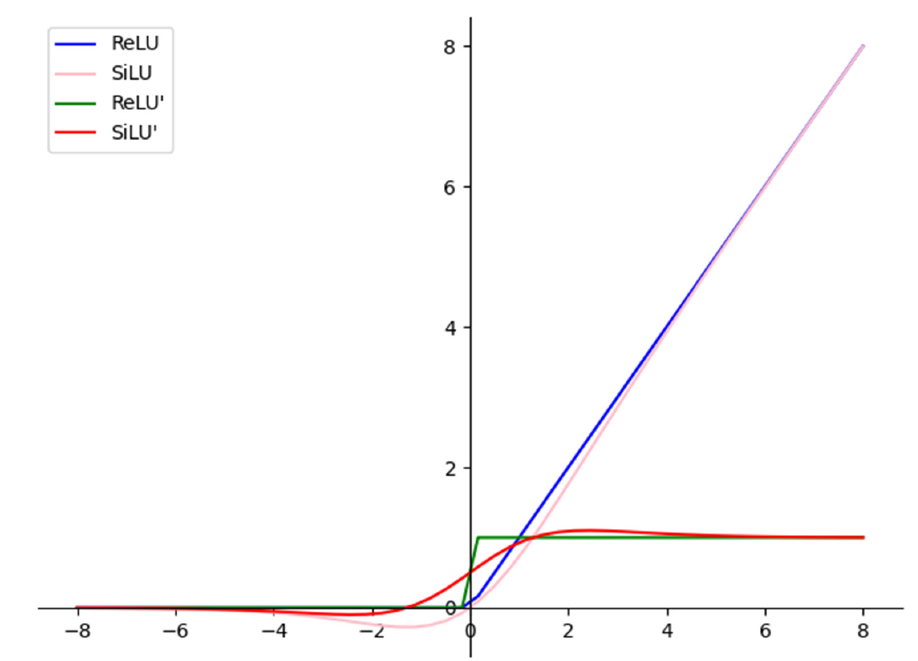
Figure 4. Activation functions and first derivative curves of ReLU and SiLU.